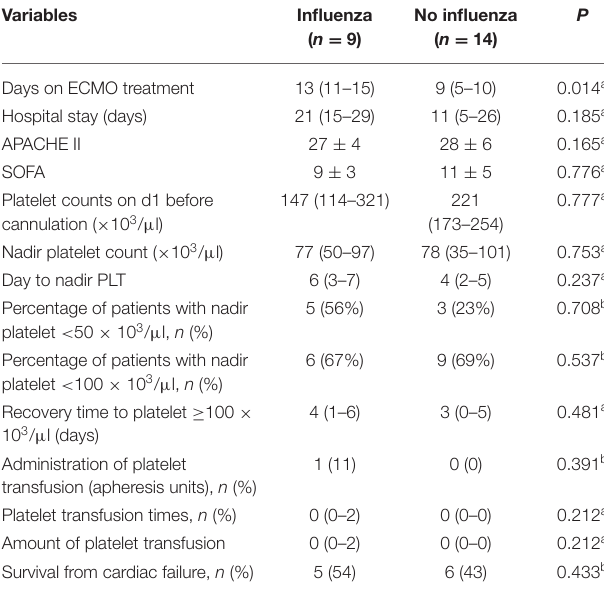
TABLE 3 | Characteristics of the patients treated with oseltamivir during hospital stay ( n = 23).